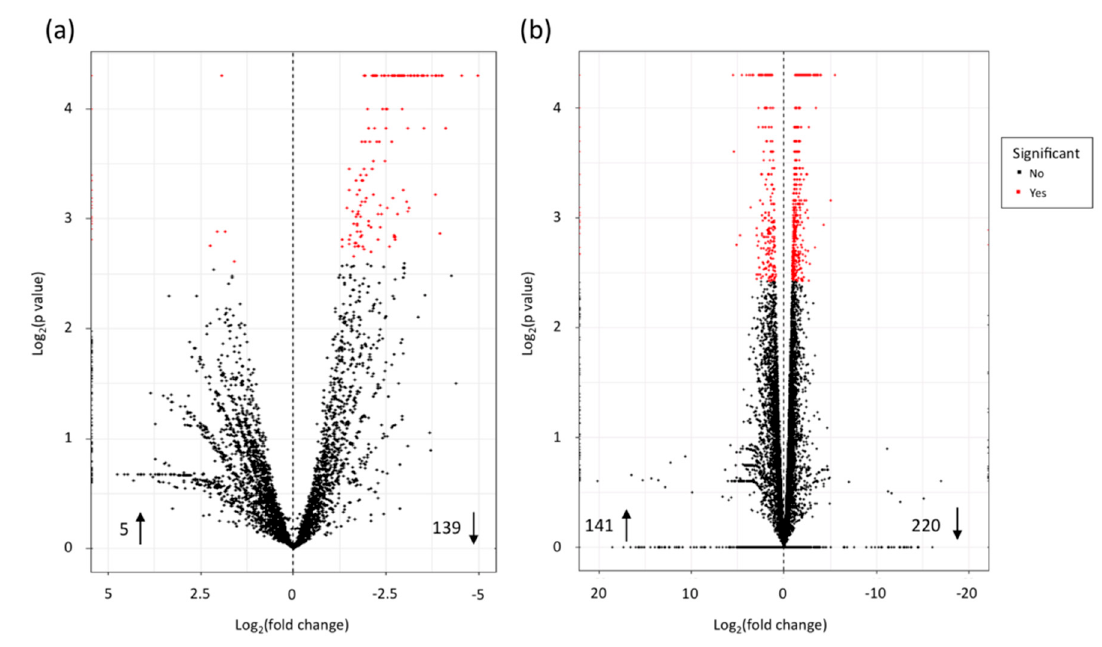
Figure 2. Volcano plots representing all expressed transcripts. For every transcript, the fold change of 12 days post inoculation (dpi) and 29 dpi was plotted against the p -value for both ( a ) Xanthomonas fragariae and ( b ) Fragaria × ananassa . Statistically significant differentially expressed genes, with a Log 2 fold change ≥ 1.5 or ≤ − 1.5, are depicted as a red dot, and insignificant as black dots. For each organism, the numbers aside the arrows pointing up represent the number of higher expressed genes and the numbers aside arrows pointing down represent the number of lower expressed genes.